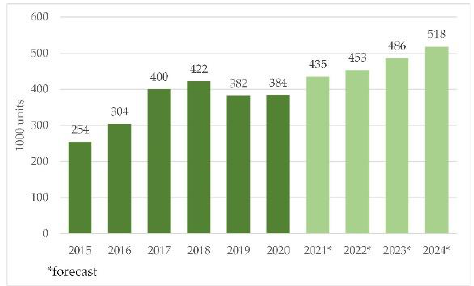
Figure 1. Global industrial robot sales and forecast to 2024 [1].